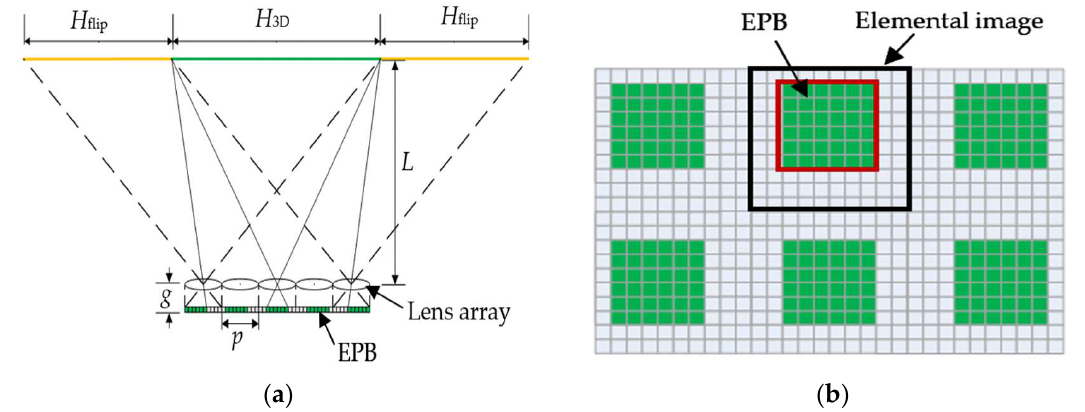
Figure 1. ( a ) Distributions of viewing zone and image flipping zones; ( b ) Effective pixel blocks within the EIA.